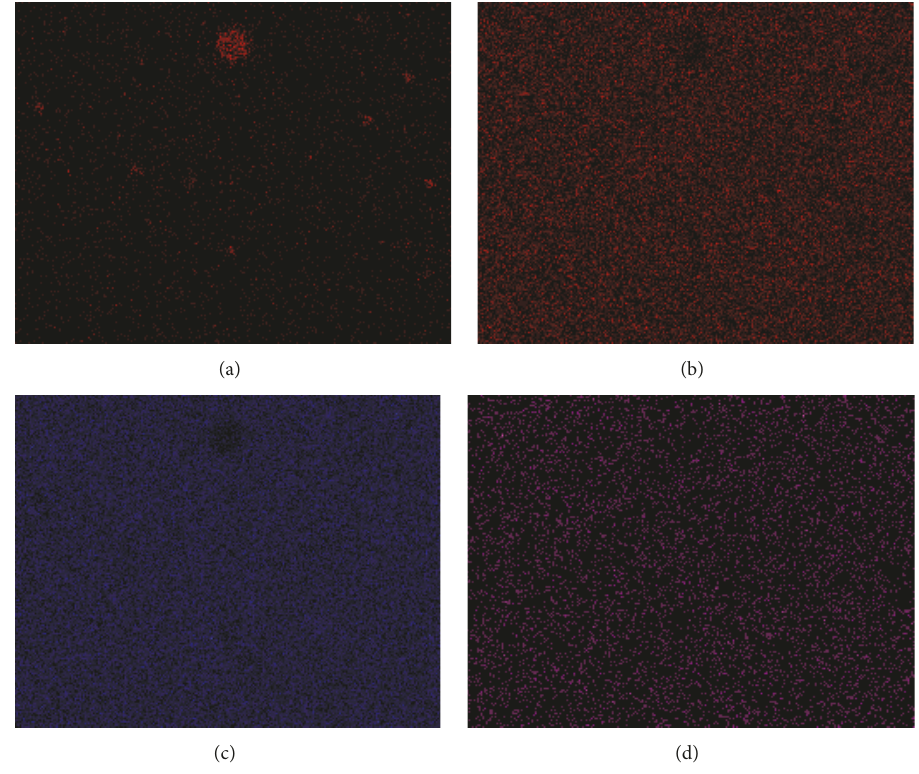
Figure 2: Element distribution in Figure 1: (a) Fe, (b) O, (c) Si, and (d) Na. The scale is shown in Figure 1.